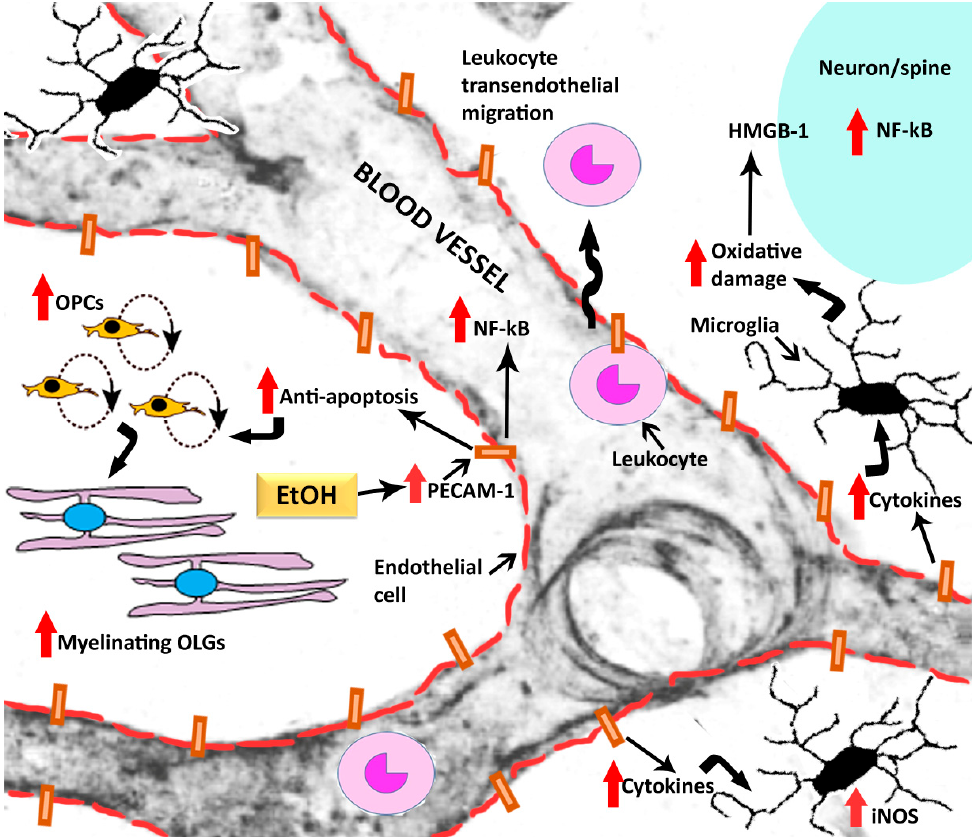
Figure 3. Schematic of blood vessel in the brain and hypothetical mechanisms of alcohol (EtOH) in the brain that are associated with alcohol-induced enhanced expression of PECAM-1. Attention is paid to include increases in expression of nuclear factor kappa b (NF-kB), activation of microglia and transendothelial migration of leukocytes as inflammatory responses post alcohol experience. Open headed arrows indicate the cell type; closed headed arrows indicate a mechanism followed by direction of effect; red thick arrows indicate increases in protein expression or effect on the signaling mechanism. OPCs, oligodendrocyte progenitor cells; OLGs, oligodendrocytes; HMGB-1, high mobility group box 1.